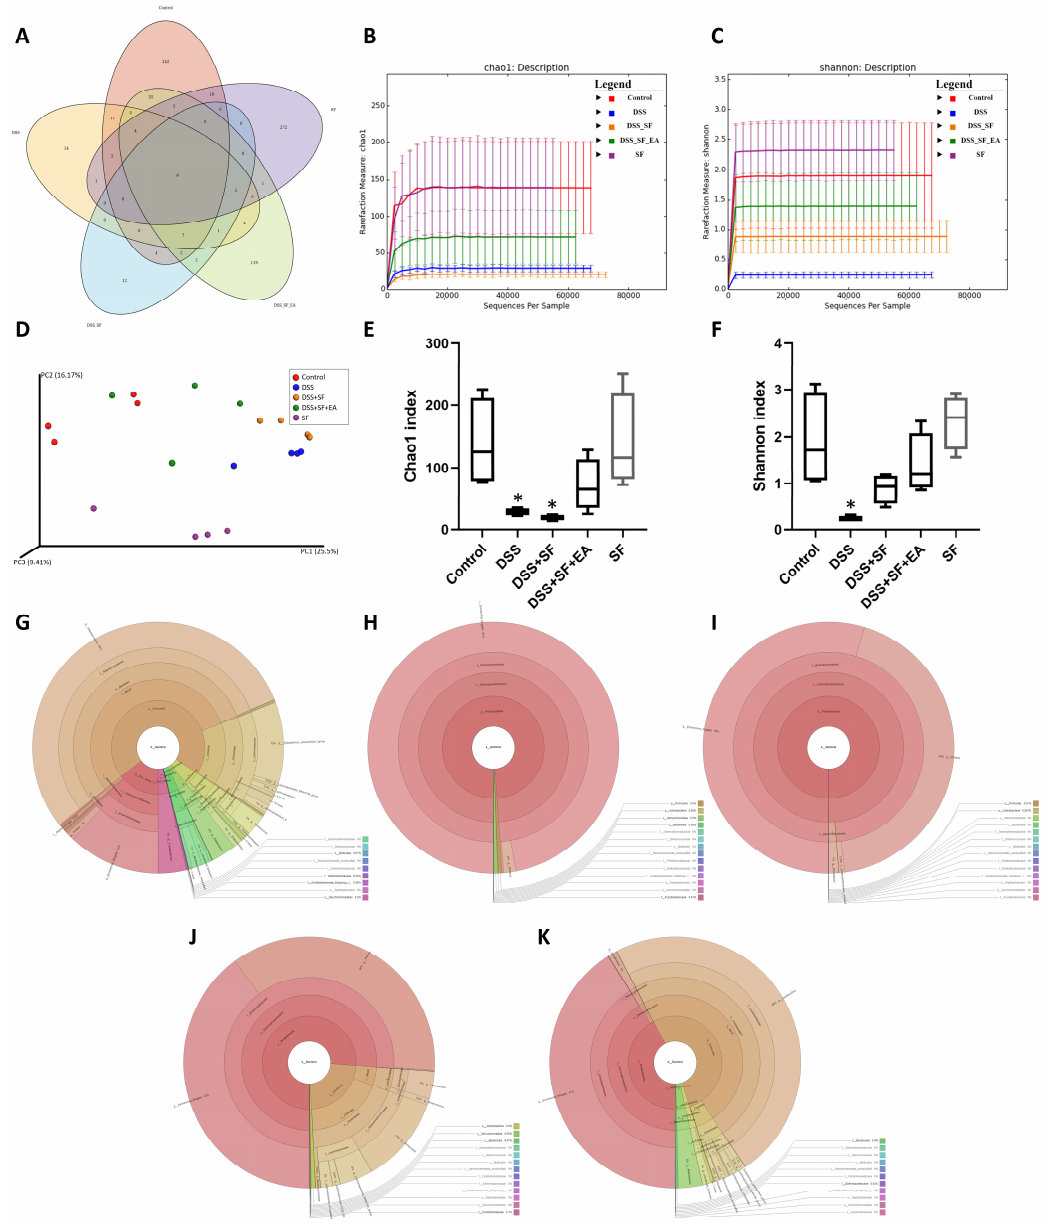
Figure 5. Evaluation of illumina MiSeq sequencing data showing that EA could maintain the species abundance and modulate the overall structure of gut microbiota in DSS-induced colitis with sleep fragmentation. ( A ) Venn diagram of OTUs in the five groups. ( B ) Rarefaction curves of Chao1, a measure of species richness. ( C ) Rarefaction curves of Shannon, a measure of species evenness. Rarefaction curves of OTUs sampling depth. Each curve represents a group. The sequences number is on the X -axis, and Chao1 and Shannon are shown on the Y -axis. ( D ) Principal Coordinates Analysis (PCoA) score. Each point represents a sample, plotted by a principal component on the X -axis and another principal component on the Y- axis, which was colored by group. ( E ) Comparison of Chao1 index in the five groups. ( F ) Comparison of Shannon index in the five groups. ( G – K ) In the interactive html result, circles show different classification levels from the phylum to the genus (inside to outside) in the community. Samples of the control group, DSS group, DSS + SF group, DSS + SF + EA group, and SF group were represented either individually (colored by each sample name) or grouped (colored by each group name). * Represents the results of compared with the control group. (( A – K ), n = 4 in each group). DSS, dextran sodium sulfate; SF, sleep fragmentation; EA,